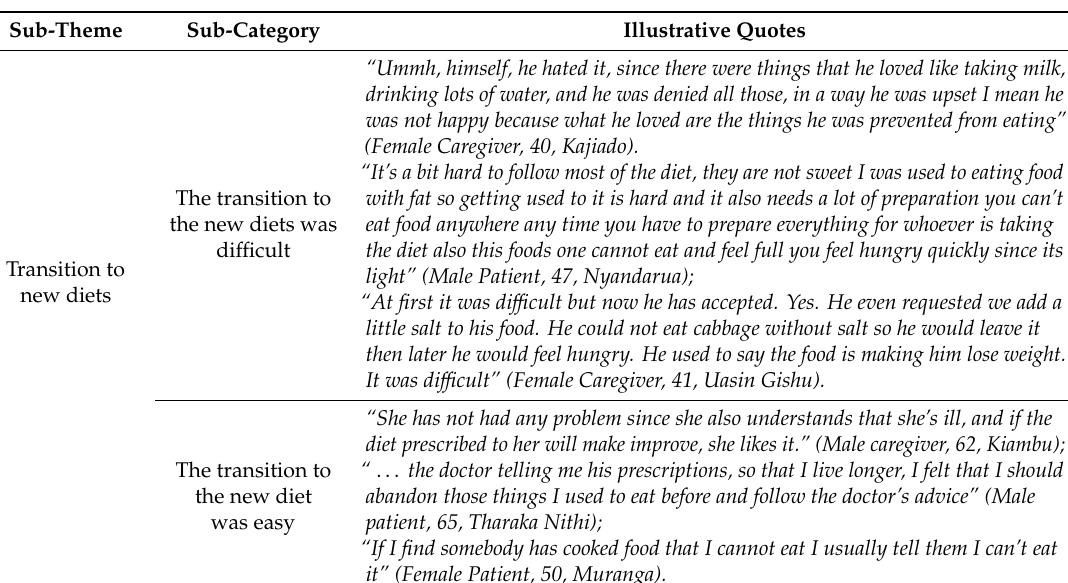
Table 5. Sub-theme 5—illustrative quotes on “transition to new diets”.